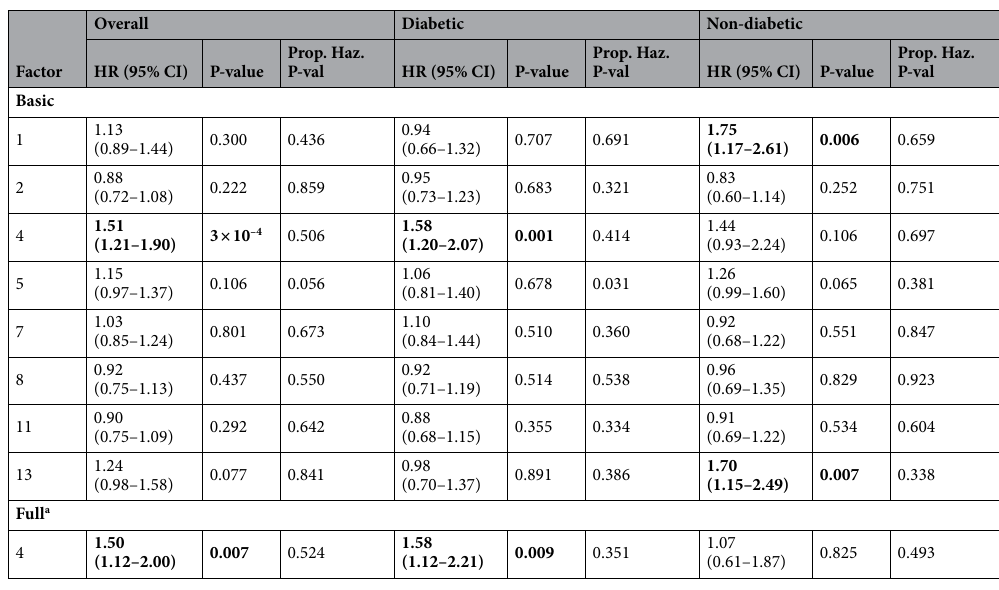
Table 6. Time-to-event analyses for baseline factor levels and death or heart failure hospitalization. Significant values are in bold. a Full model: time to heart failure hospitalization or death ~